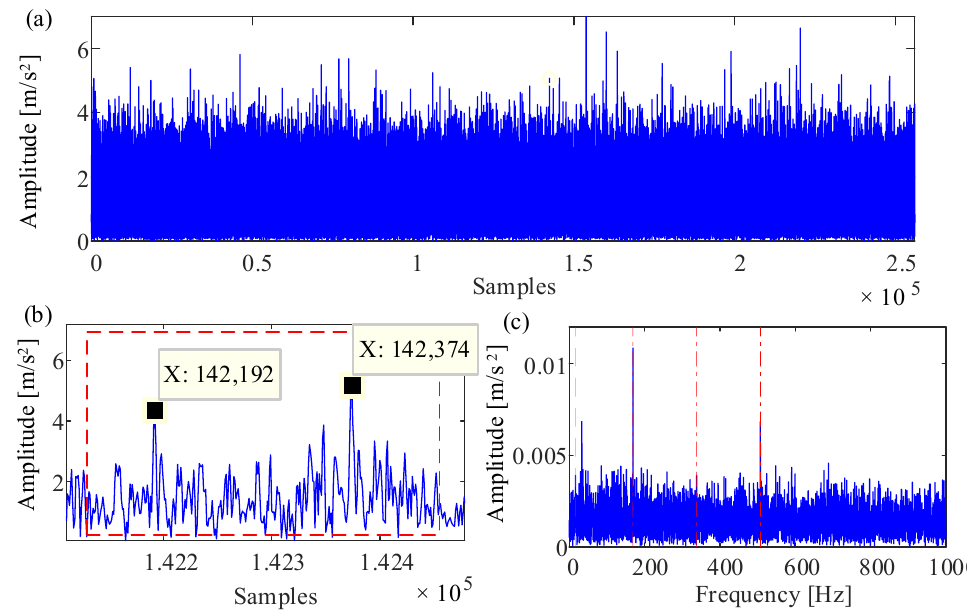
Figure 13. The results of experimental analysis at 1000 rpm: ( a ) envelope signal filtered by AR and MED; ( b ) the local signal of ( a ); ( c ) the envelope spectrum of ( a ).